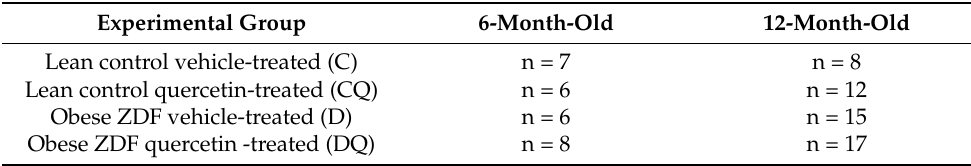
Table 2. The count of experimental animals in individual groups. Experimental Group 6-Month-Old